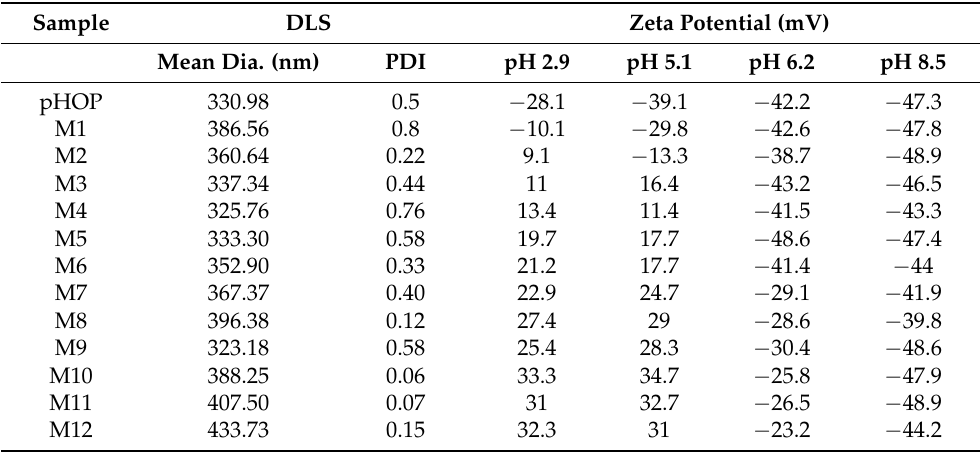
Table 2. Mean diameter, PDI and Zeta potential values as obtained from DLS and Zeta potential measurements for different pHOP-NH 2